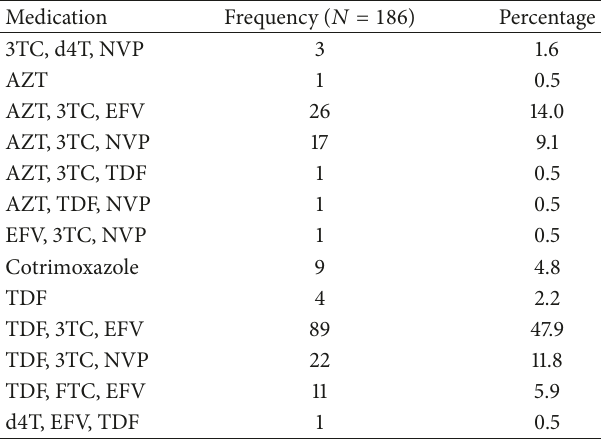
Table 4: Antiretroviral drugs being taken by participants. Table 5: Participants first CD4 count results before taking antiretro- viral medication.